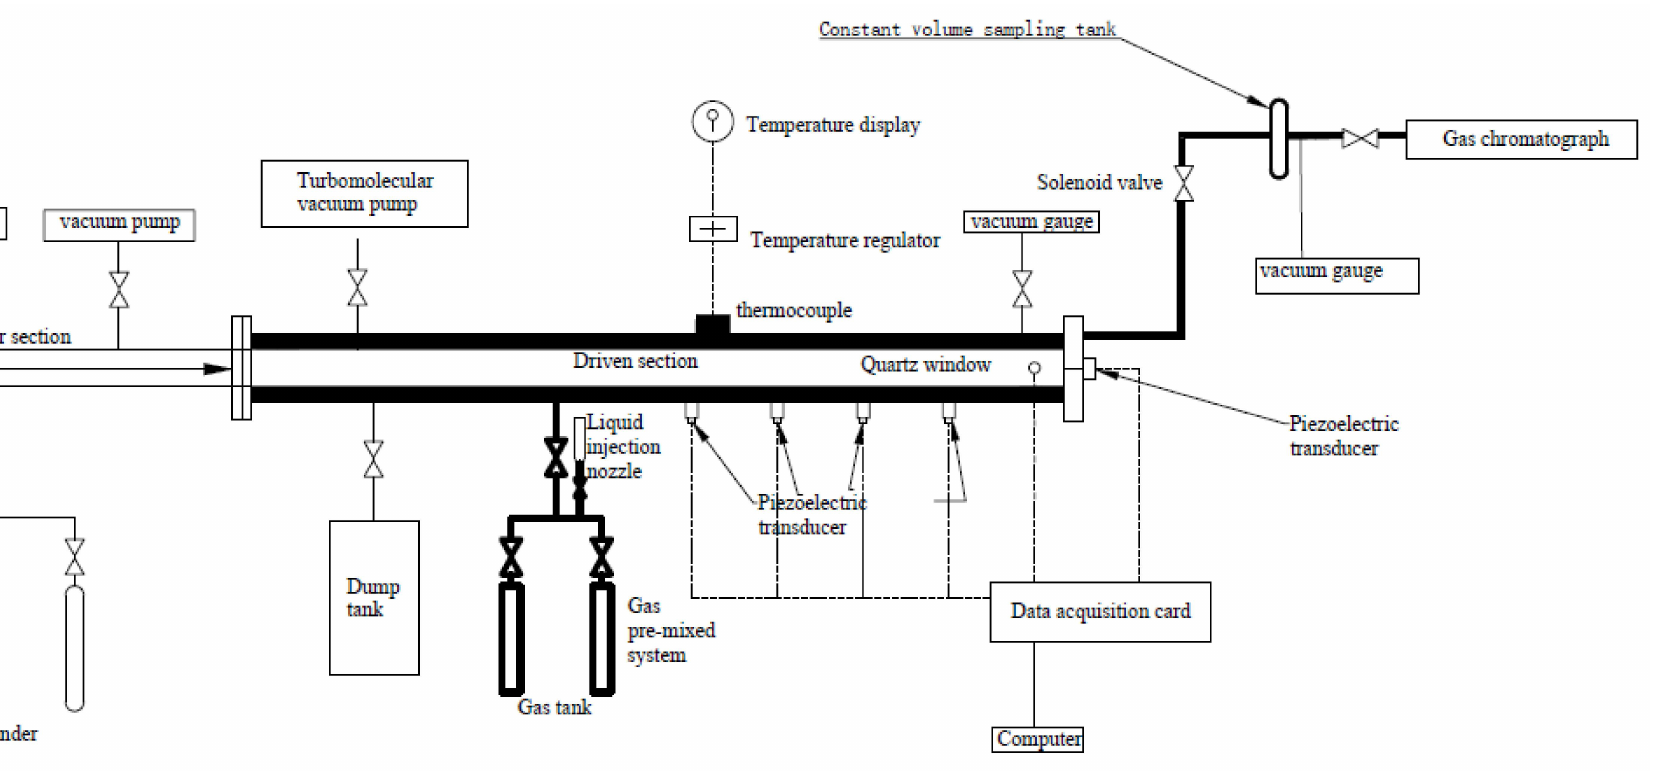
Figure 2. Single-pulse shock tube schematic